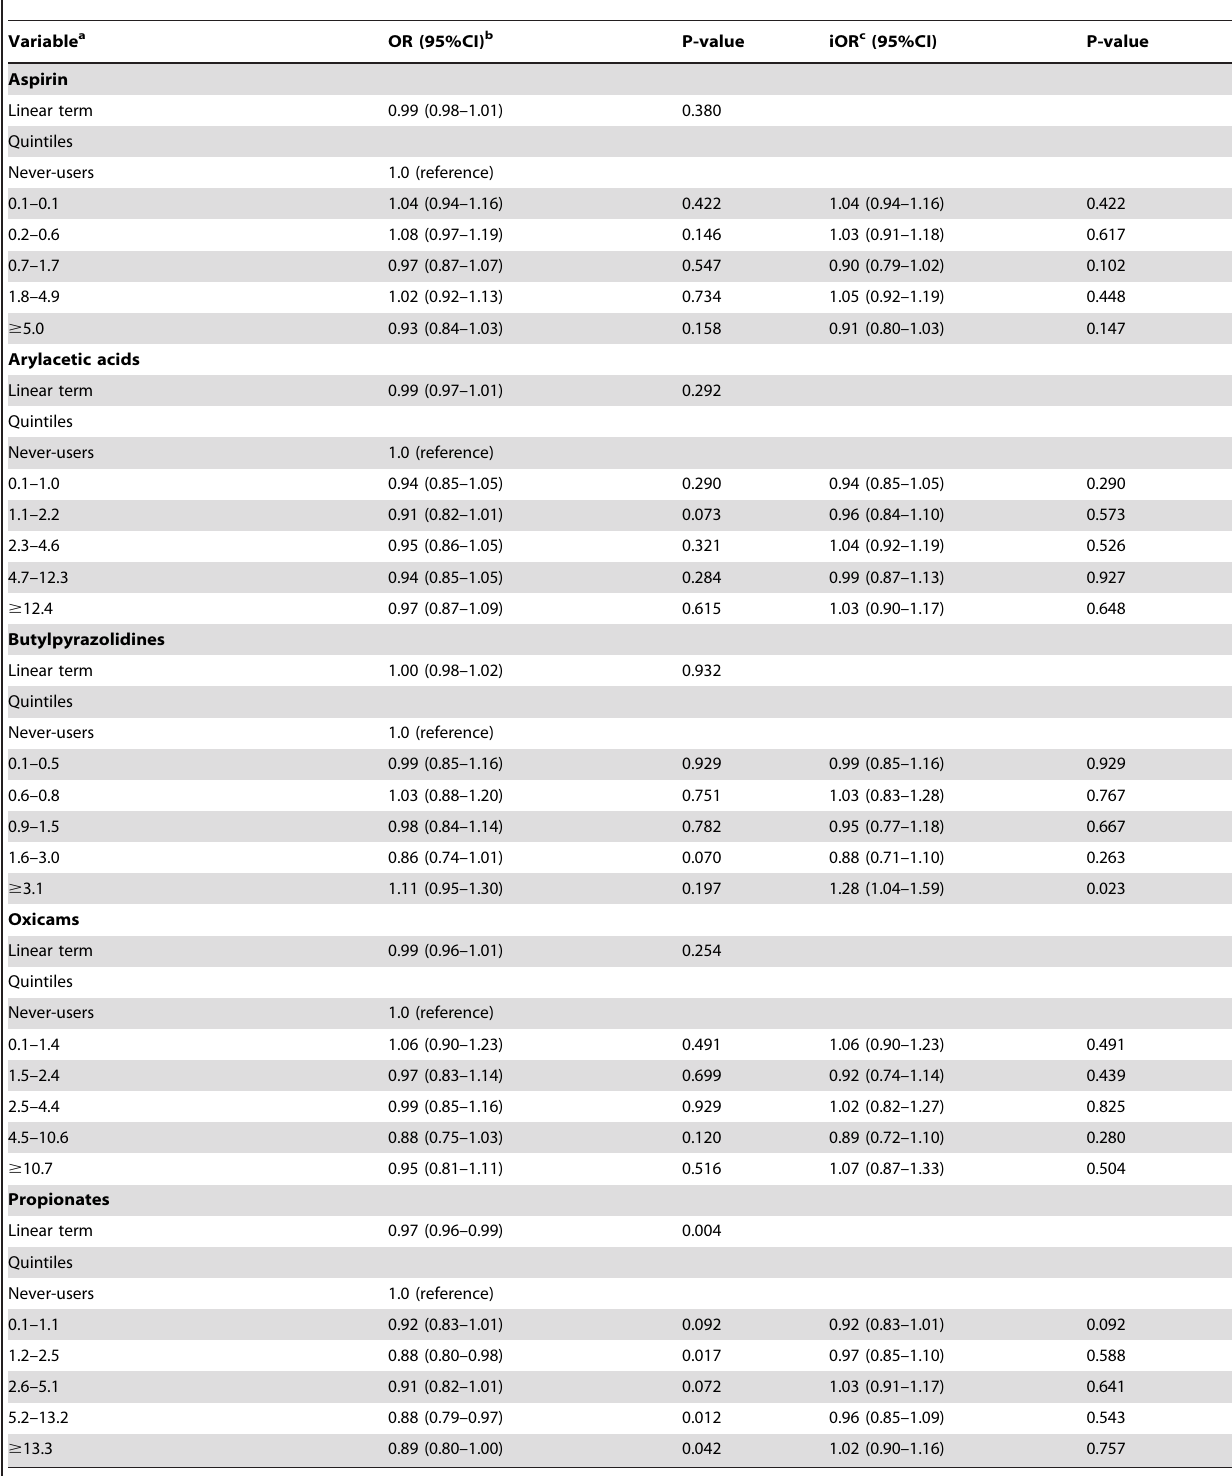
Table 4. Effect of average annual NSAID dose (in DDDs/year; categorized using the quintiles of the distribution) on the risk of developing prostate